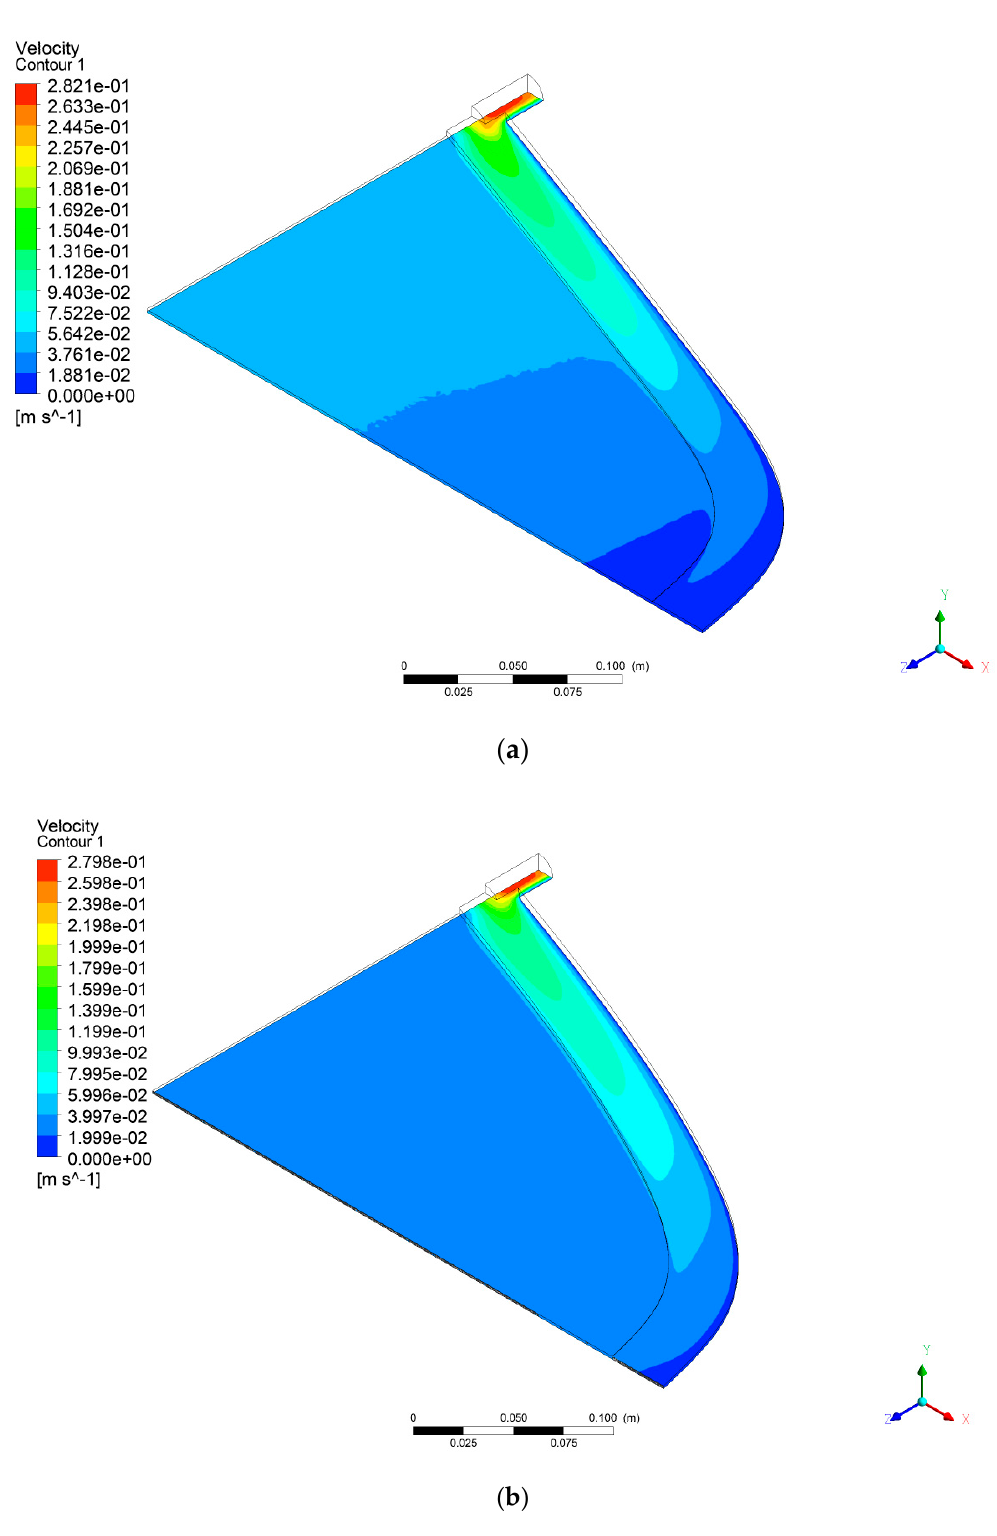
Figure 7. Velocity distribution in ( a ) the initial die and ( b ) optimized die.